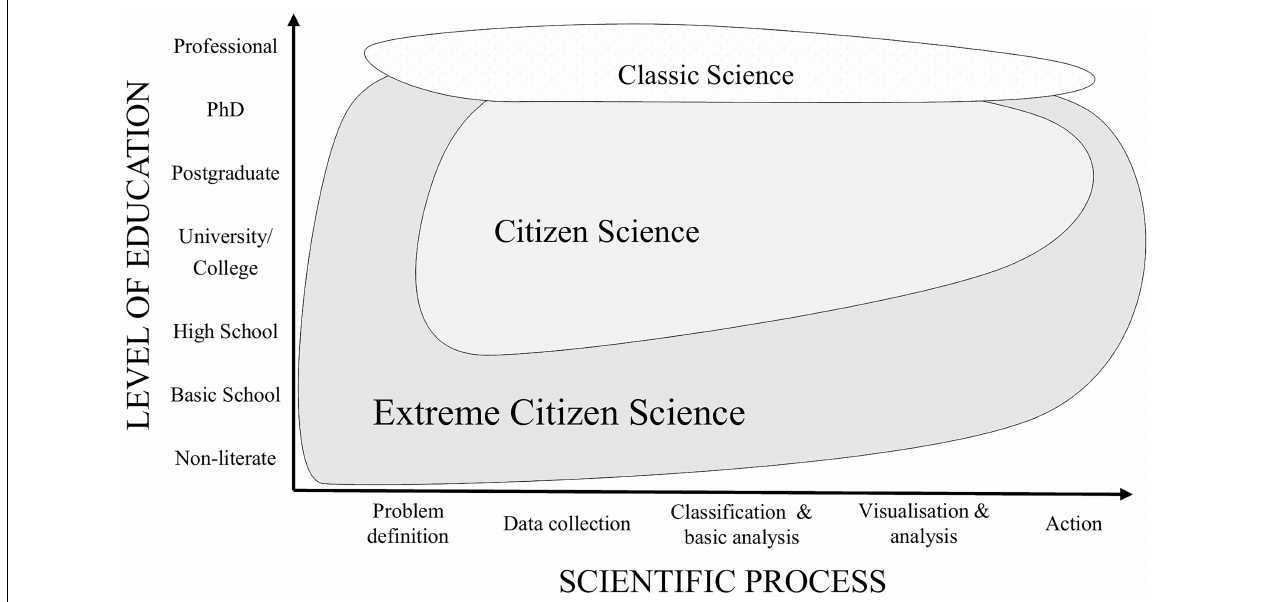
FIGURE 1 | Positioning Extreme Citizen Science (ECS) within the scope of citizen